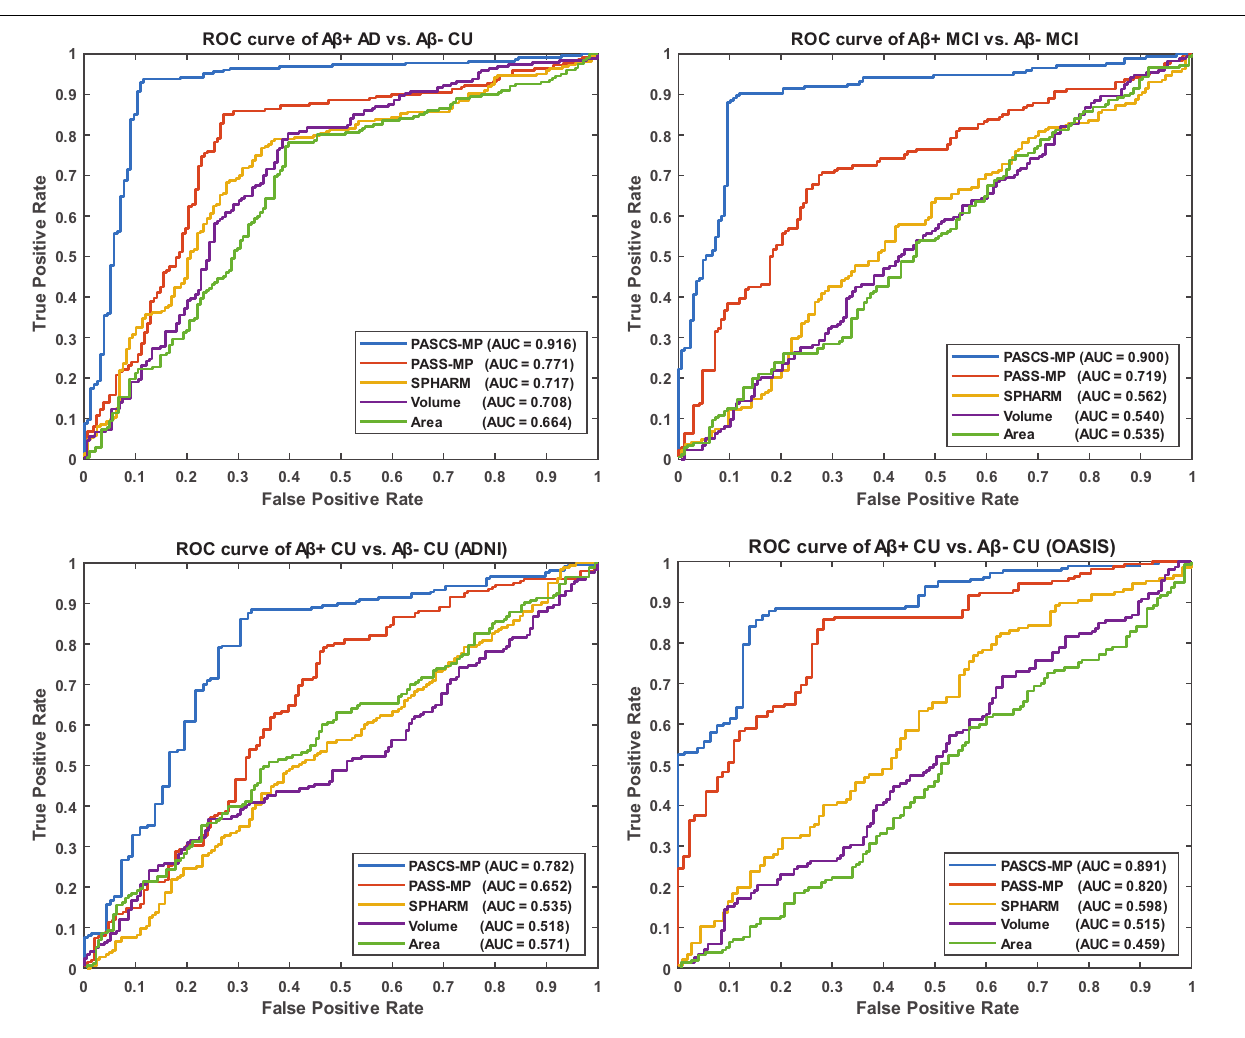
FIGURE 4 | Receiver operating characteristic curves for the classification tasks, A β + AD vs. A β – CU, A β + MCI vs. A β – MCI, A β + CU vs. A β – CU (ADNI), and A β + CU vs. A β – CU (OASIS). OASIS is used as an external validation set for the model trained by ADNI